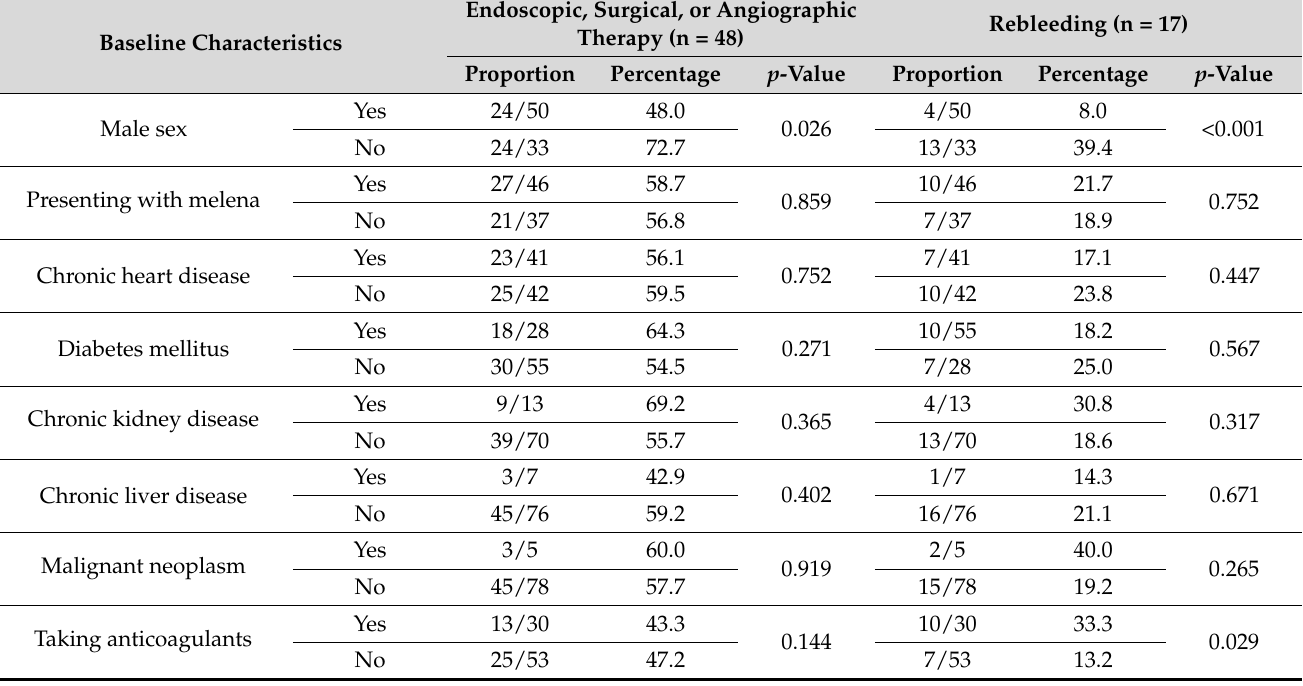
Table 4. Comparison of characteristics among patients submitted to endoscopic or surgical therapy and presenting rebleeding (univariate analysis).